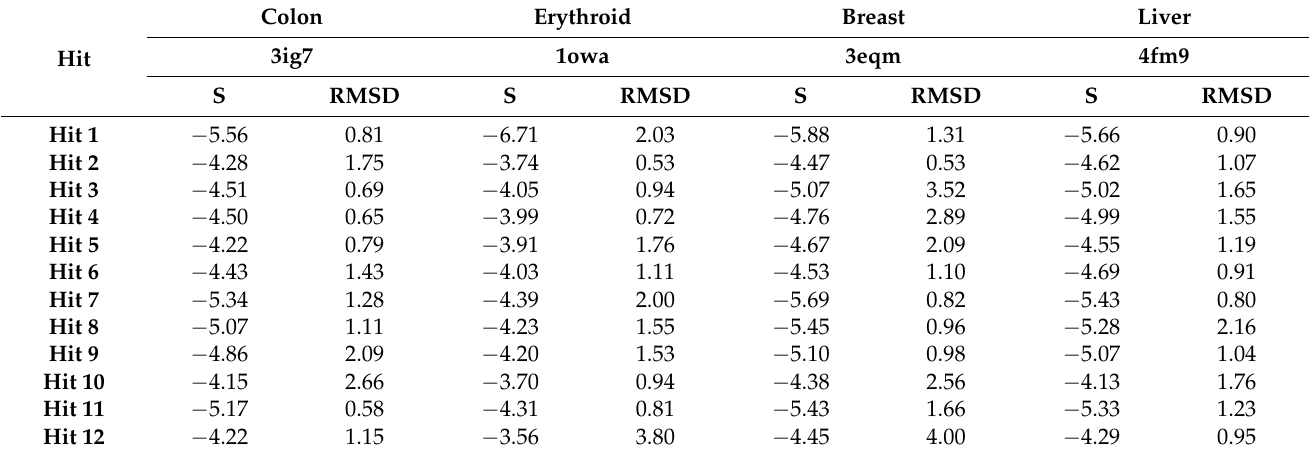
Table 3. Docking score (S) and root-mean-square deviation (RMSD) of all Hit compounds as ligand molecules against target proteins 3ig7, 1woa, 3eqm, and